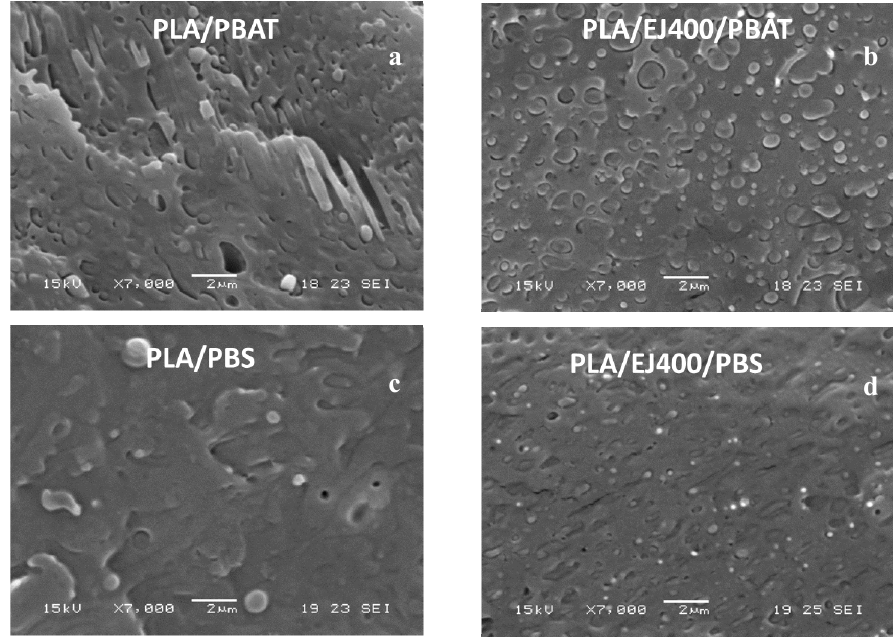
Figure 1. SEM micrographs onto cryogenic fractures samples of Poly(lactic acid) (PLA)/poly(butylene adipate- co -terephthalate) (PBAT) and PLA/poly(butylene succinate) (PBS) blends prepared in a laboratory extruder also in the presence of EJ400: ( a ) PLA/PBAT blend; ( b ) PLA/EJ400/PBAT blend; ( c ) PLA/PBS blend; ( d ) PLA/EJ400/PBS. Table 2. Tensile tests performed on laboratory extruded PLA/PBAT and PLA/PBS blends by using EJ400 as reactive plasticizer.